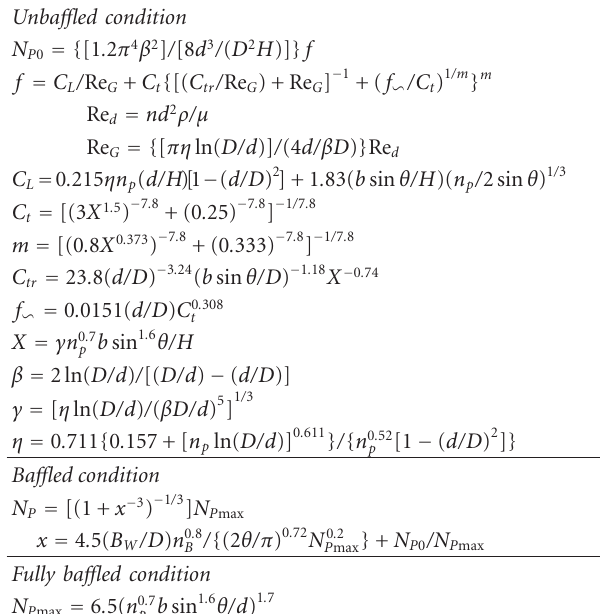
Table 2: Correlation equations of power number for pitched paddle (b).